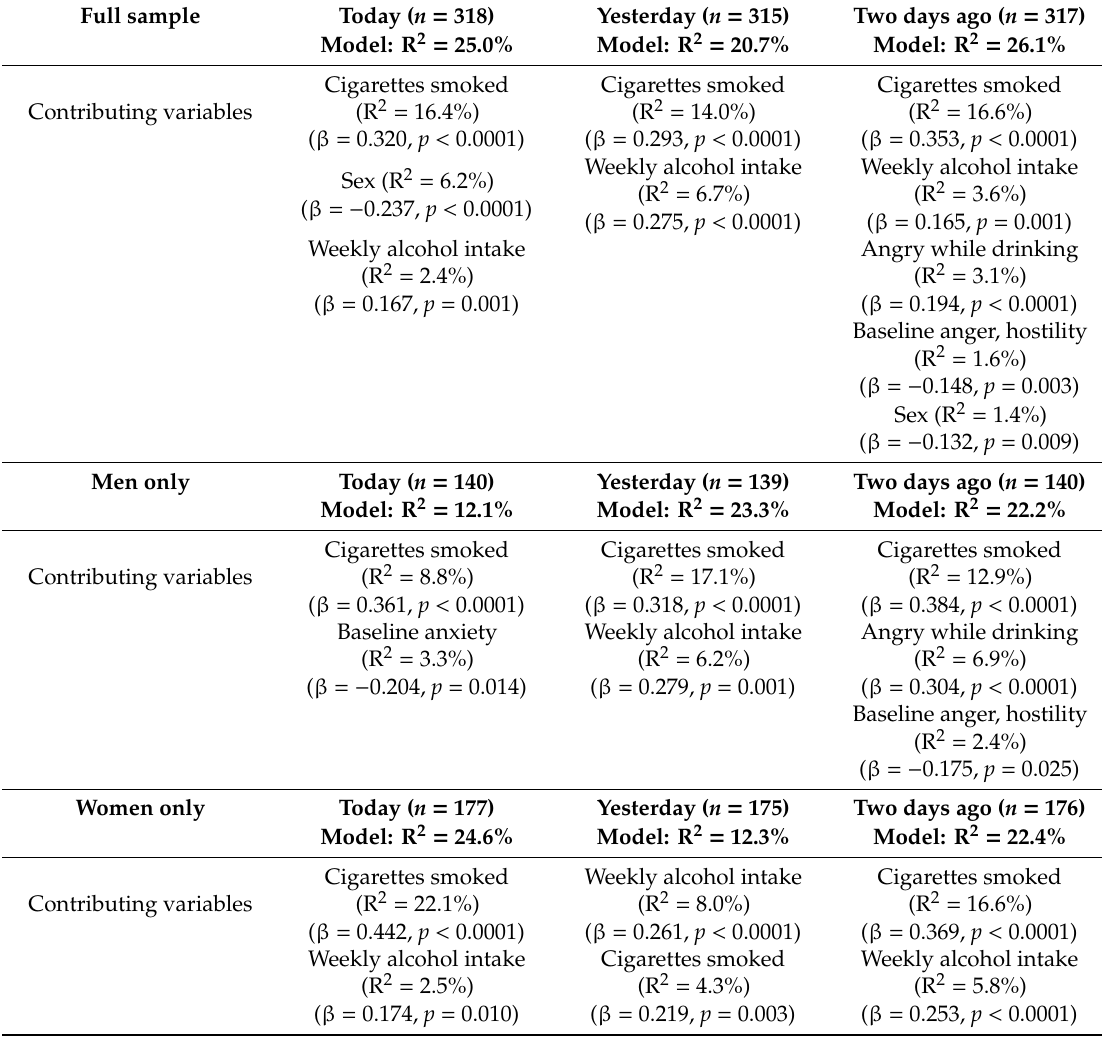
Table 5. Significant predictors of alcohol consumption. Table 6. Significant predictors of subjective intoxication.